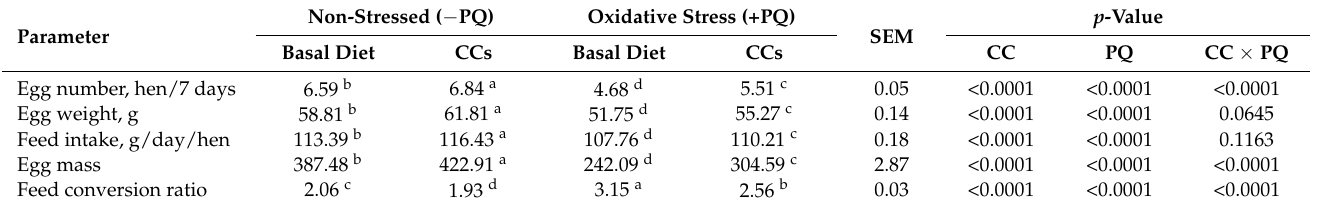
Table 4. Production performance of layers subjected to paraquat-induced oxidative stress (PQ) and dietary Citrullus colocynthis seed supplementation